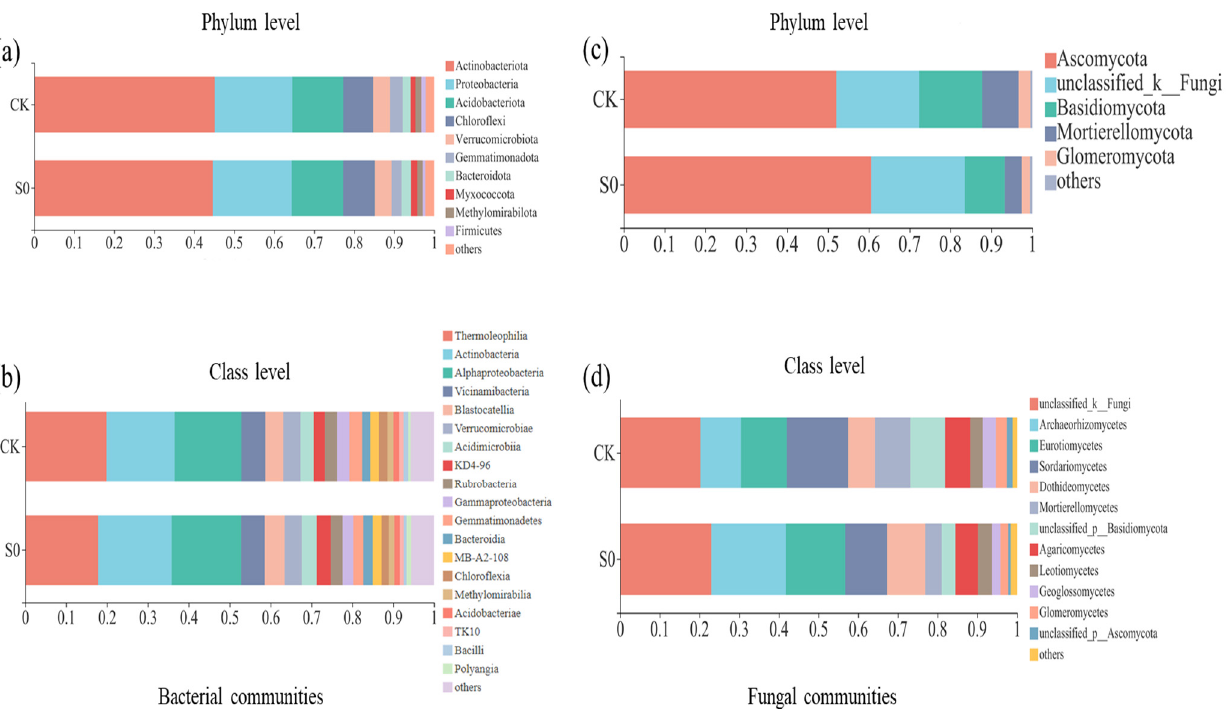
Figure 1. Relative abundance of bacterial communities at the phylum ( a ) and class ( b ) level, and fungal communities at the phylum ( c ) and class ( d ) level in the snow removal (S0) and control (CK) plots during the spring thawing period (March 2020). Taxa accounting for <1% were integrated into the group ‘other’.